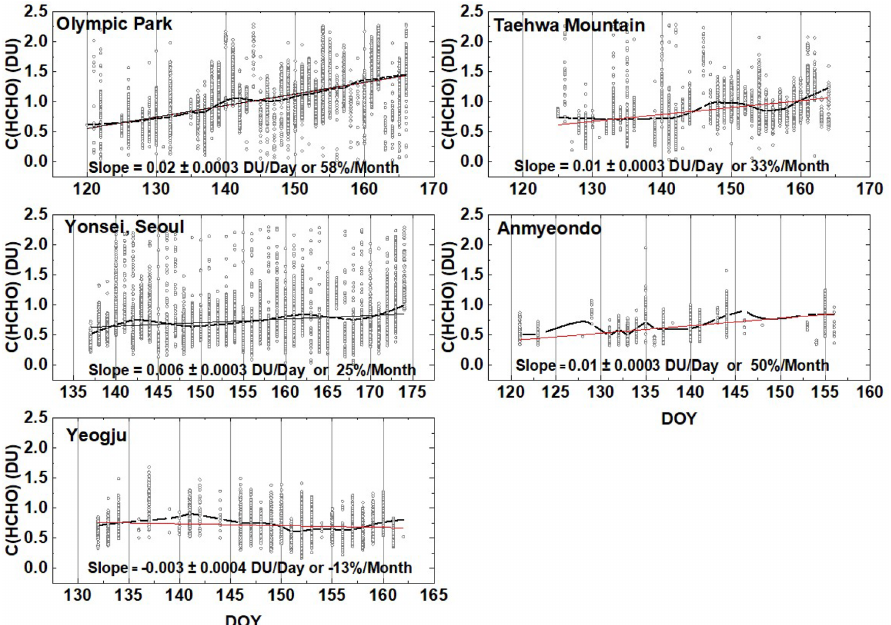
Figure 20. The springtime change in C(HCHO) over about a 40 day period depending on the site. The “vertical bars” are the diurnal variation within each day of data. The thicker red curve is a Lowess(0.3) fit to the data, while the thin red line is a linear least squares fit. The Lowess(0.3) fit is approximately a 10-day local least-squares average.